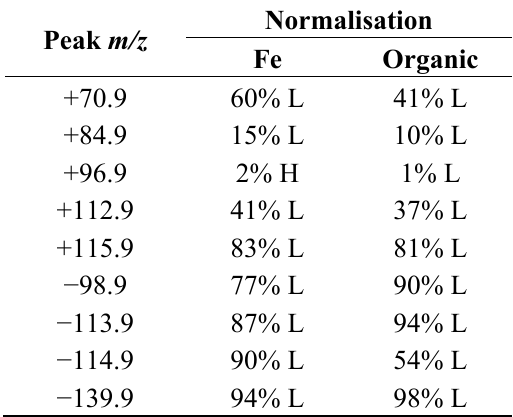
Table 5. Intensities of Fe-containing diagnostic secondary ion peaks from conditioned magnetite surfaces compared with those from bulk Fe hydroxamate (L: lower, H: higher); peak intensities have been normalised relative to the intensities of both Fe ion and organic fragment ion peaks as in Table